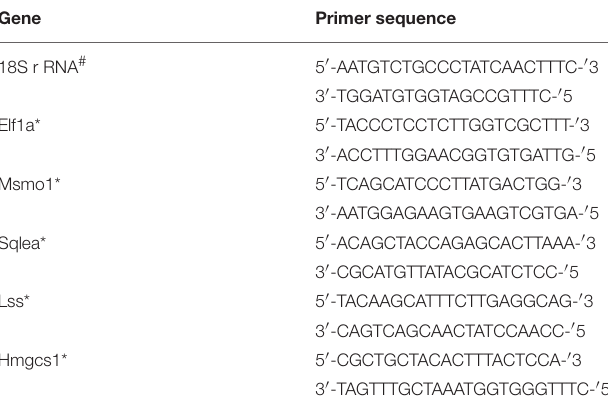
TABLE 1 | Primer sequences used for qPCR